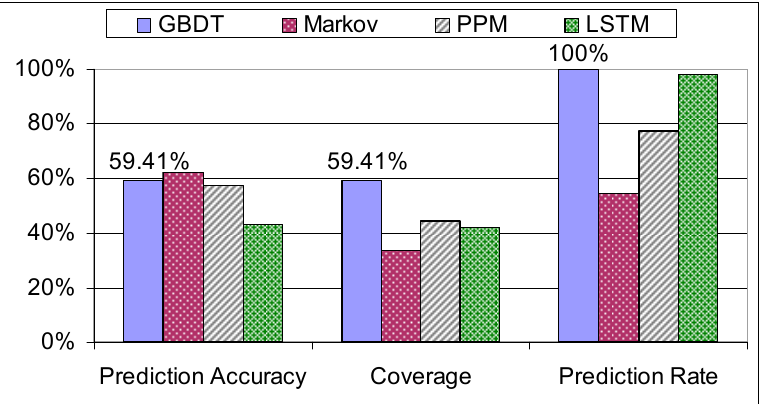
Figure 14. Comparison on the “Trainees” dataset.